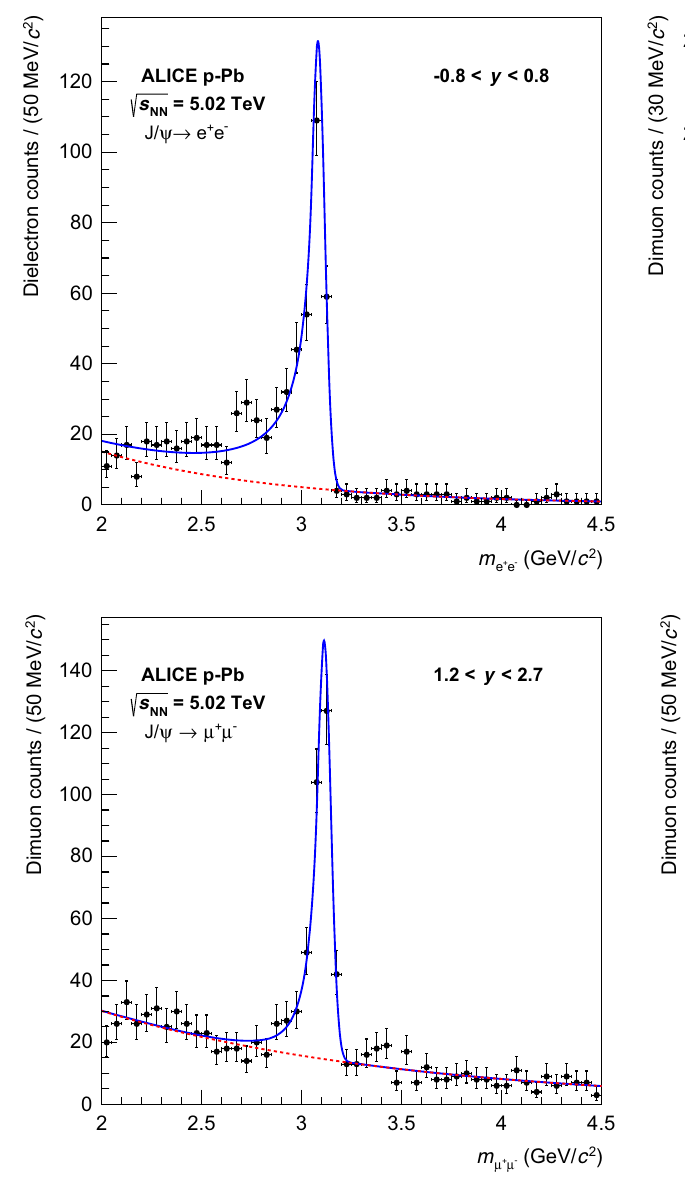
by points with error bars. The solid blue line is a fit to a Crystal-Ball function plus an exponential distribution, where this last contribution is shown by a dotted red